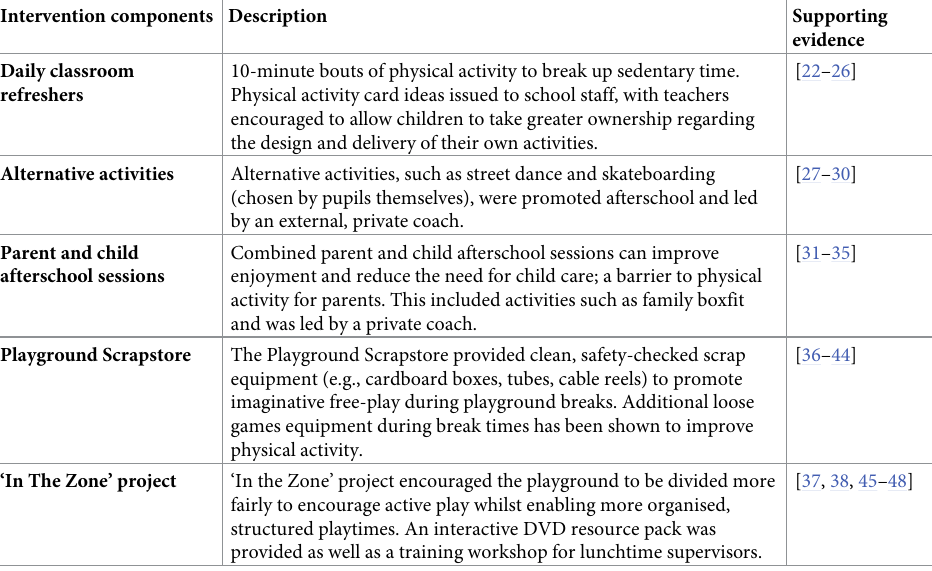
Table 1. Intervention components with descriptions and supporting